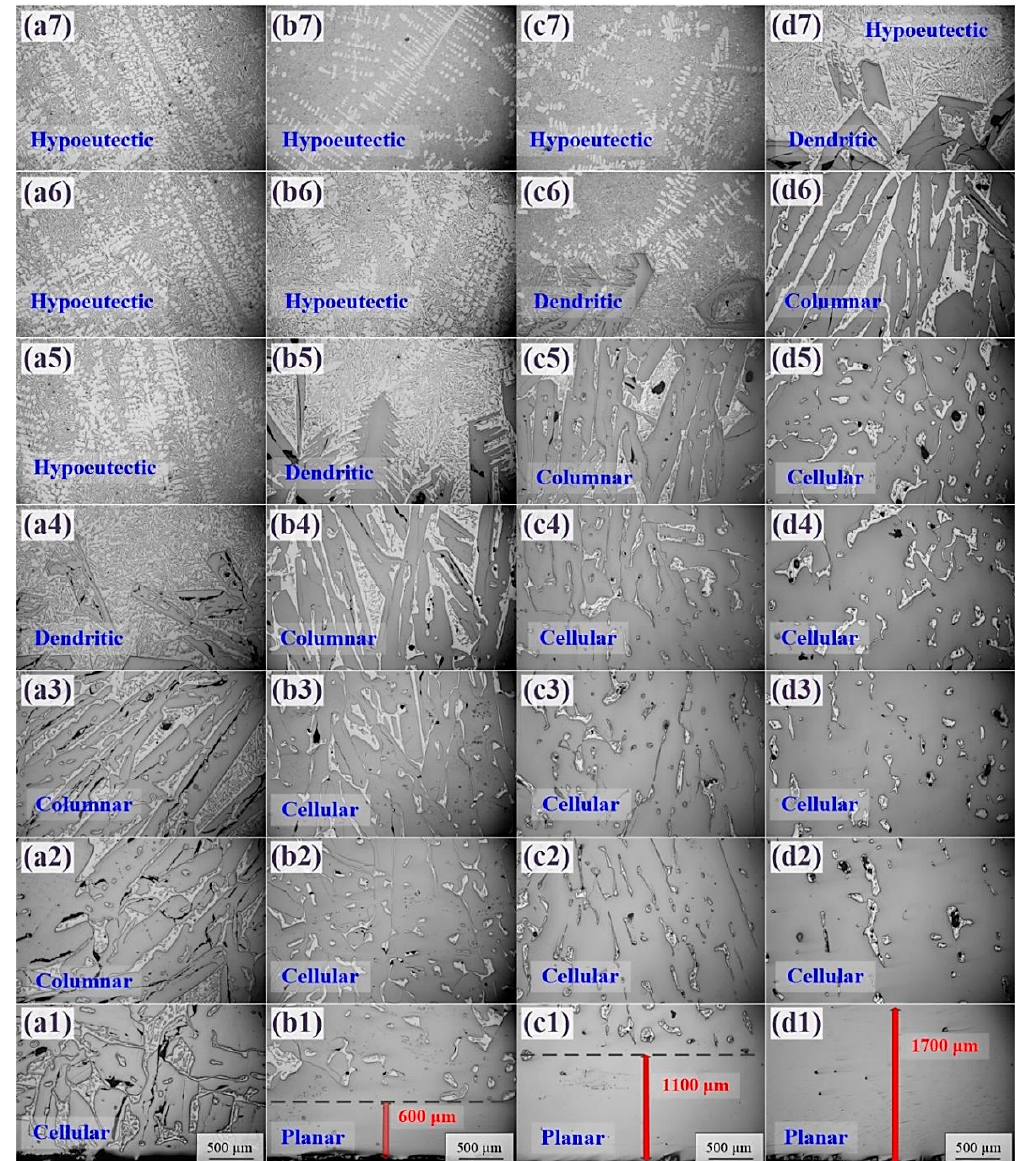
Figure 3. Microstructures of the solidified alloys with EMDS: ( a ) Al-35 wt.% Si, ( b ) Al-45 wt.% Si, ( c ) Al-55 wt.% Si, and ( d ) Al-65 wt.% Si.